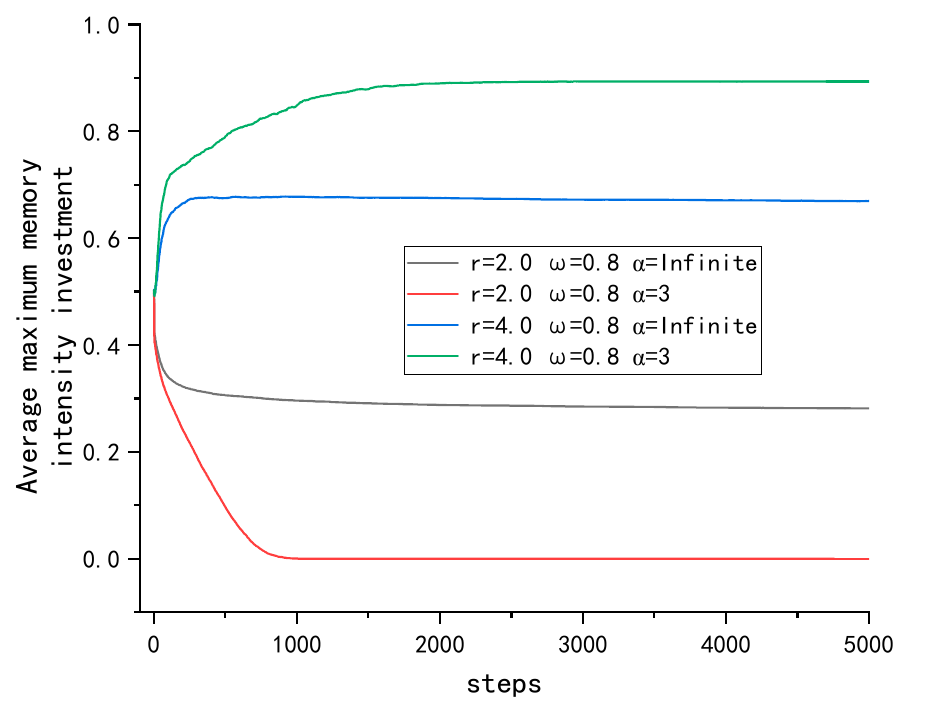
Figure 12. Evolution of the mean value of investment in maximum-intensity memory over time for different combinations of 𝑟 and 𝛼 at 𝜔 = 0.8 .